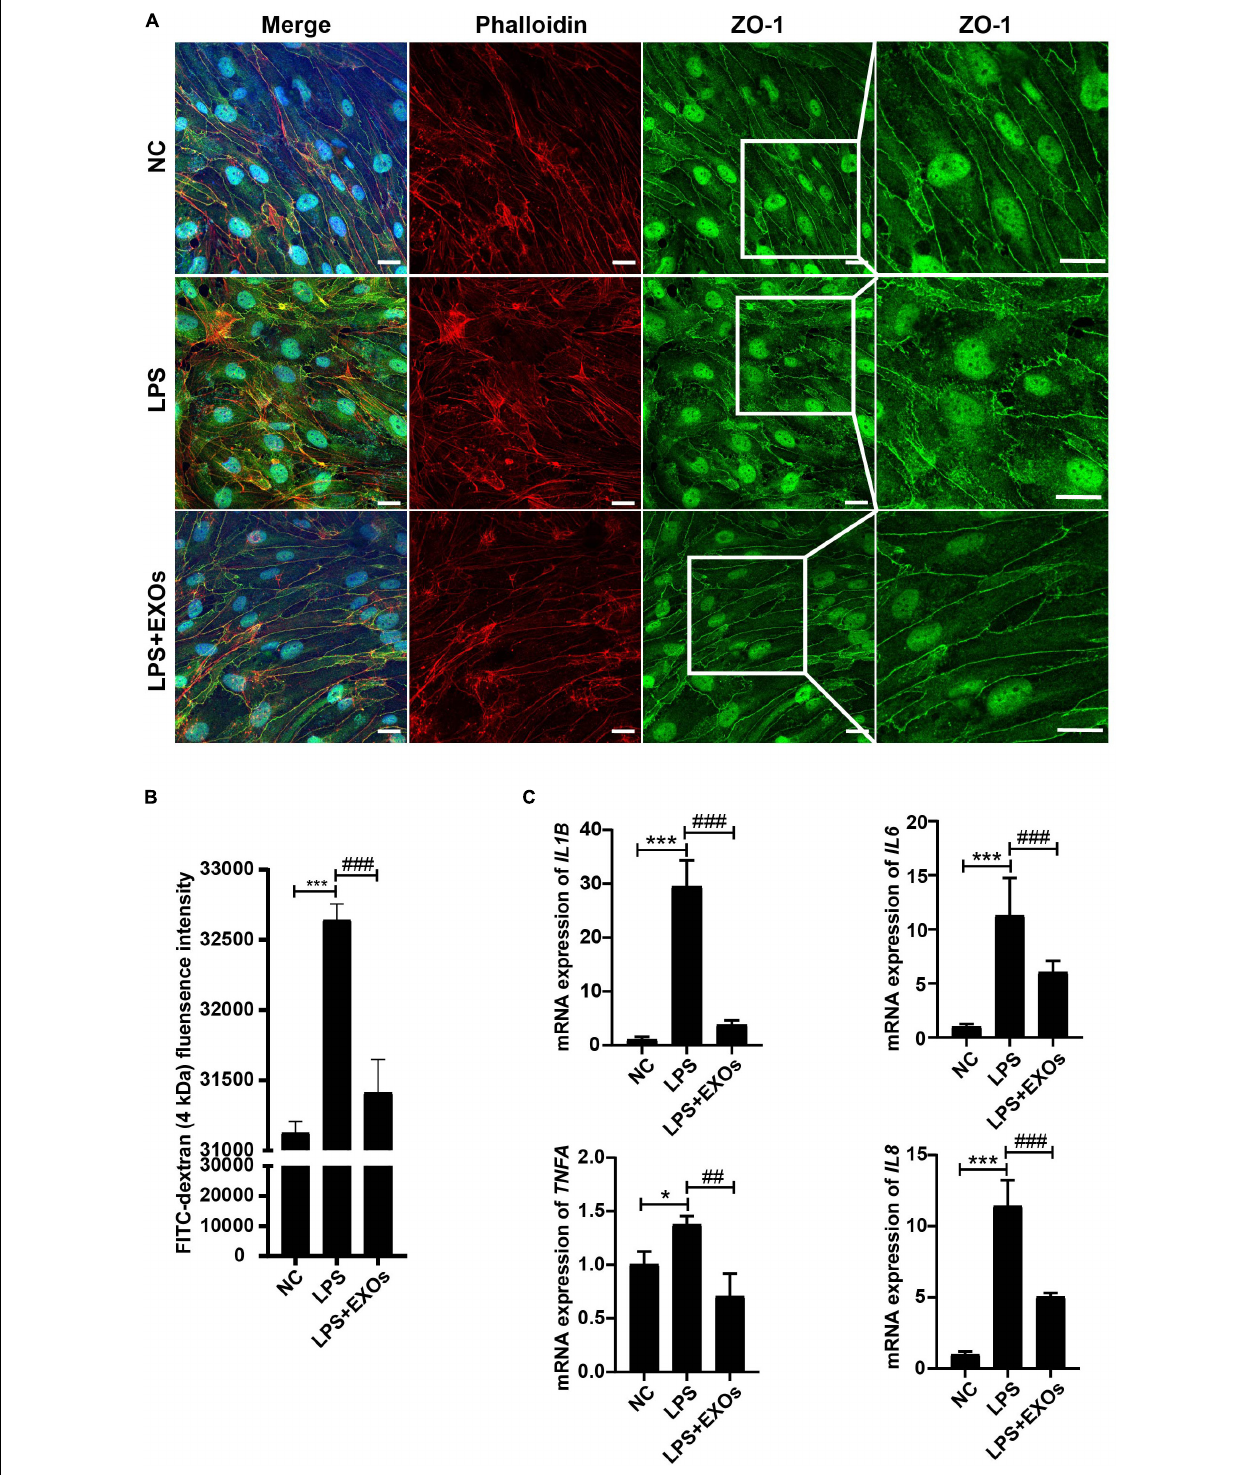
FIGURE 6 | EXOs had beneficial effects on endothelial integrity. (A) Confocal images of human umbilical vein endothelial cells (HUVECs) grown on transwells and treated with lipopolysaccharide (LPS) or LPS plus EXOs. Scale bar = 20 µ m. (B) Fluorescein isothiocyanate (FITC)-dextran permeability assay of HUVECs on transwells in the indicated groups ( n = 3). *** P < 0.001 vs. the normal control (NC) group; ### P < 0.001 vs. the LPS group. (C) The mRNA expression of inflammatory mediators in HUVECs 24 h after LPS stimulation and EXOs treatment. * P < 0.05, *** P < 0.001 vs. the NC group; ## P < 0.01, ### P < 0.001 vs. the LPS